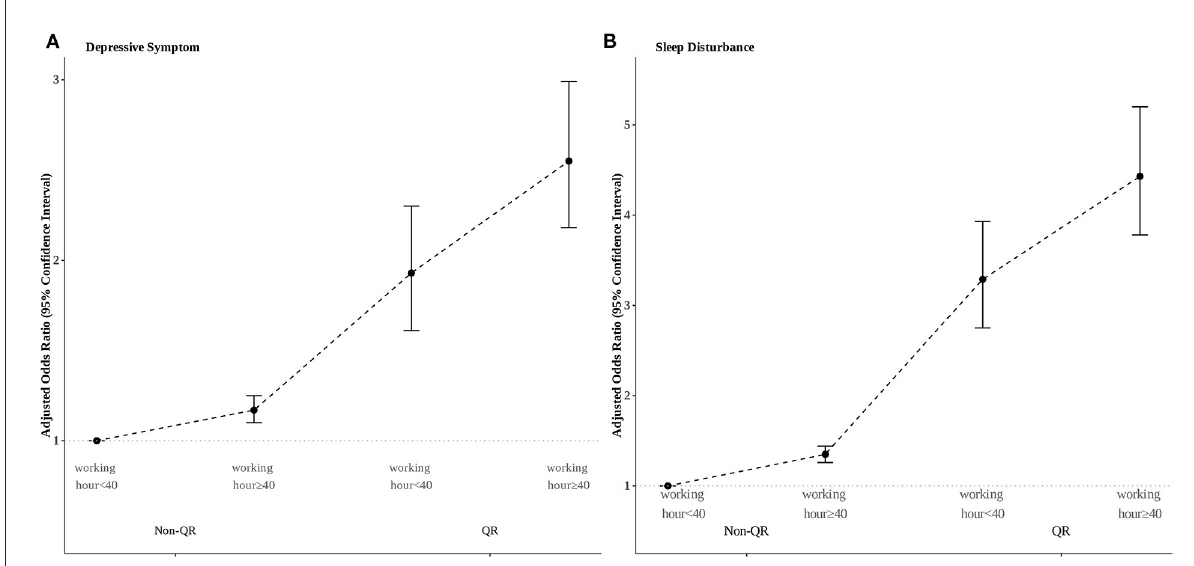
FIGURE1 Interaction analysis of long working hours and quick return on (A) depressive symptoms and (B) sleep